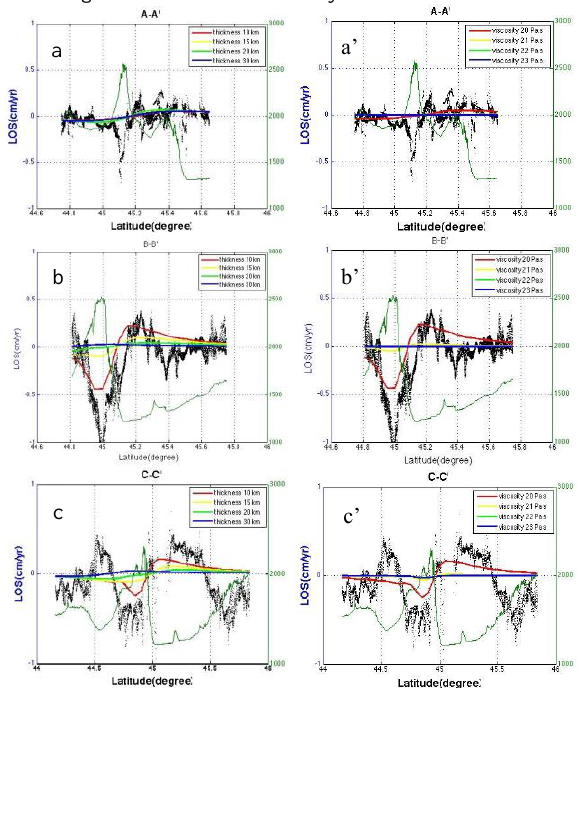
Figure 6. Optimal viscoelastic relaxation model (with upper layer thickness 10 km, viscosity 9×10 19 Pa s) for the Gobi-Altai fault. Velocity components predicted from VISCO1D viscoelastic relaxation model. Thick black line marks the fault trace. T276, T4, T233 and T462 refer to SAR tracks 276, 4, 233 and 462, marked by thin black line boxes. Colour scale shows line-of-sight deformation rate in